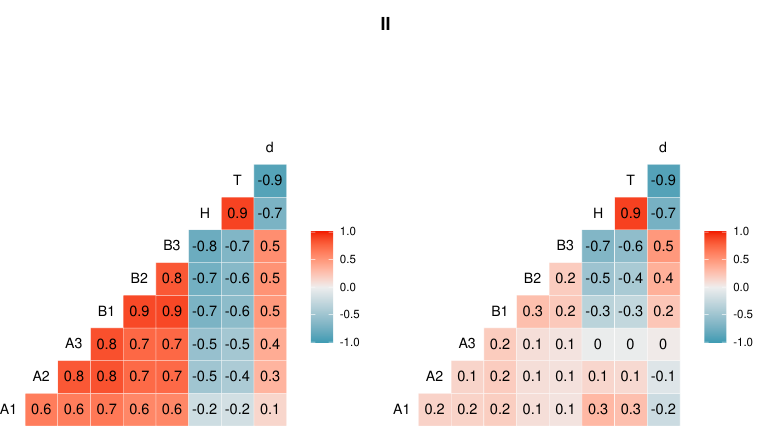
Figure 5. Pearson correlations between the features A 1 , A 2 , A 3 , B 1 , B 2 , B 3 , cumulative death hazard H, survival time T, and death status in synthetic datasets type ( I ) (high correlation) and ( II ) (low correlation).